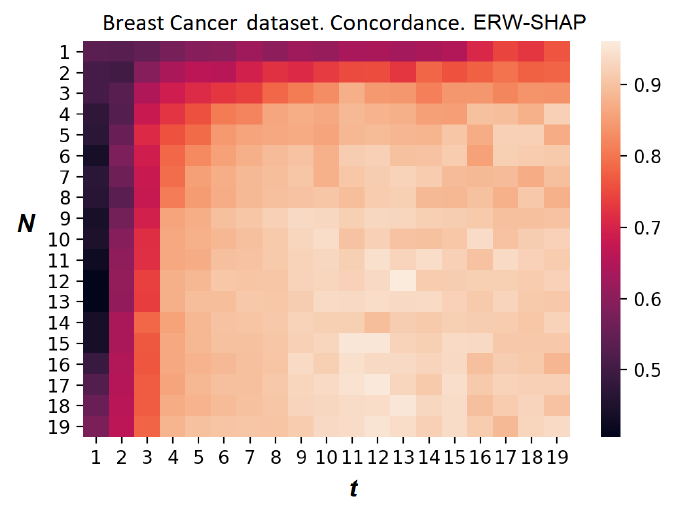
Figure 24. The heatmap reflecting the concordance index C obtained by ERW-SHAP for the Breast Cancer